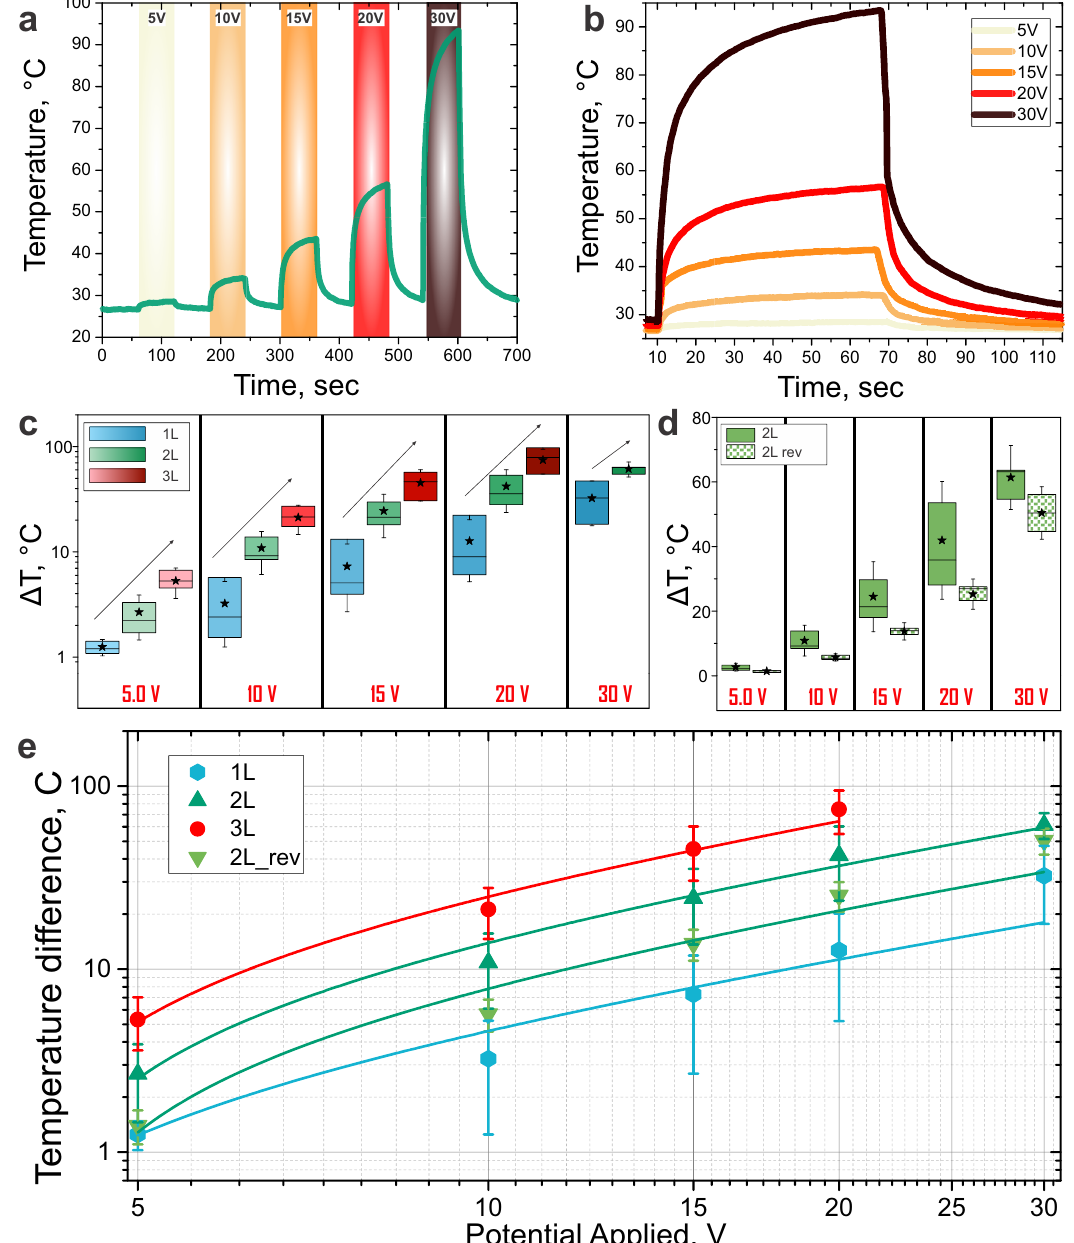
Fig. 5 GETs wearable heater ef fi ciency. a Real time-temperature pro fi le of a 2L-GET heated by applying 5 V, 10 V, 15 V, 20 V, and 30 V consequently. b Real temperature measured for a 2L-GET, overlapped. c The overall heating ef fi ciency for 1L-GETs (blue, N = 11), 2L-GETs (green, N = 17), and 3L-GETs (red, N = 19), with y scale representing the effective raise in temperature rather than the real temperature. d Direct comparison of the heating ef fi ciency between the 2L-GETs and 2L-reversed GETs. The box represents 25% and 75% with a mean, whiskers are ±SD. e The heating ef fi ciency of the 1L-GETs (blue hexagons), 2L-GETs (dark green upwards triangles), 2L-reversed GETs (light green downwards triangles), and 3L-GETs (red circles) at different applied DC